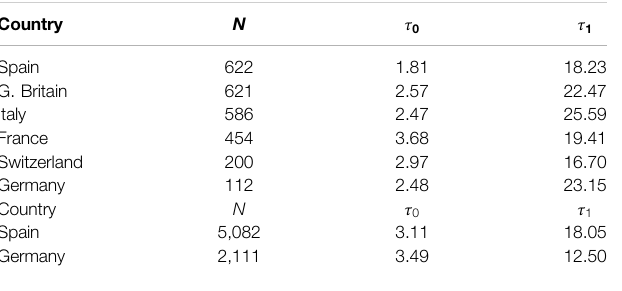
TABLE 3 | Parameters for SIR model ( fi rst wave). N (number of individuals), τ 0 and